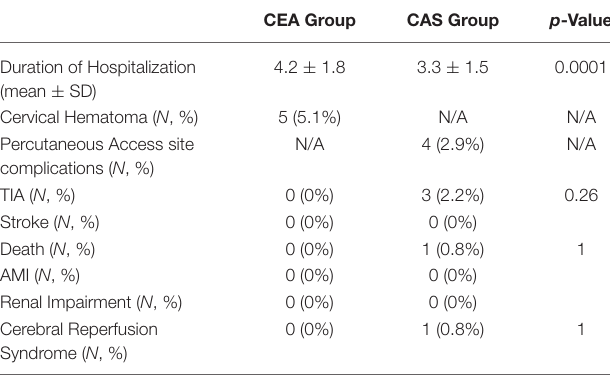
TABLE 4 | Early in-hospital and 30-day outcomes.